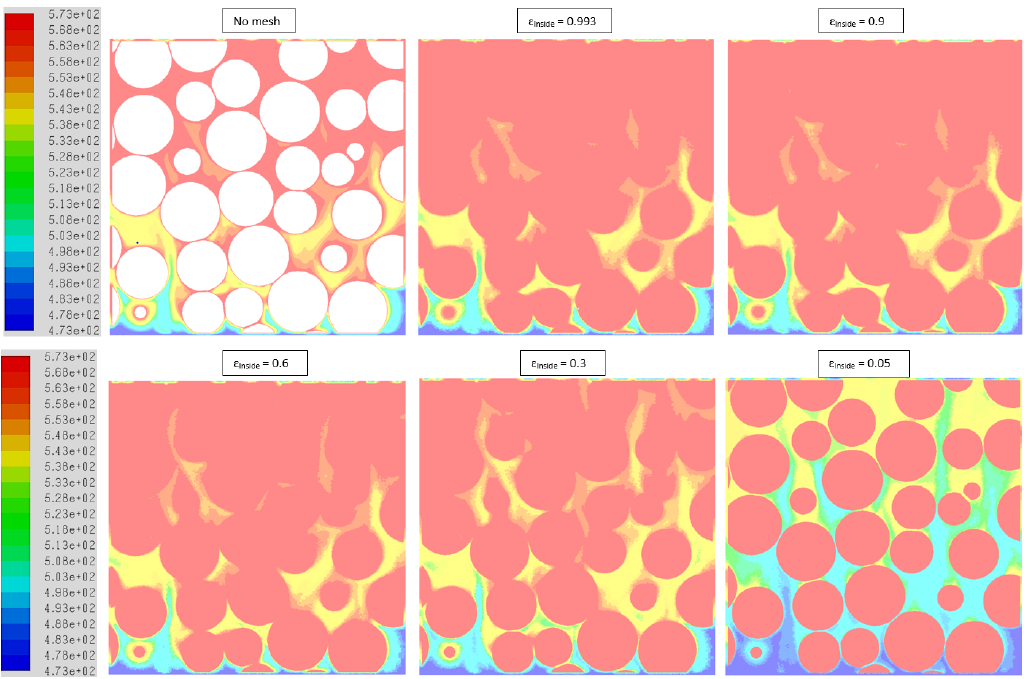
Figure 2. The contour plots for fluid temperature (K) (at plane y = 0, through a bed of ε = 0.351, Re = 100, Pr = 1). [Top left: (No mesh) represents the case without inside particle mesh [19]; in all other plots ԑ inside represents the particle porosity in each case]. The edge of low temperature at the inlet and outlet is because of the added volume region to avoid meshing problems; this does not affect the overall Nusselt number obtained.